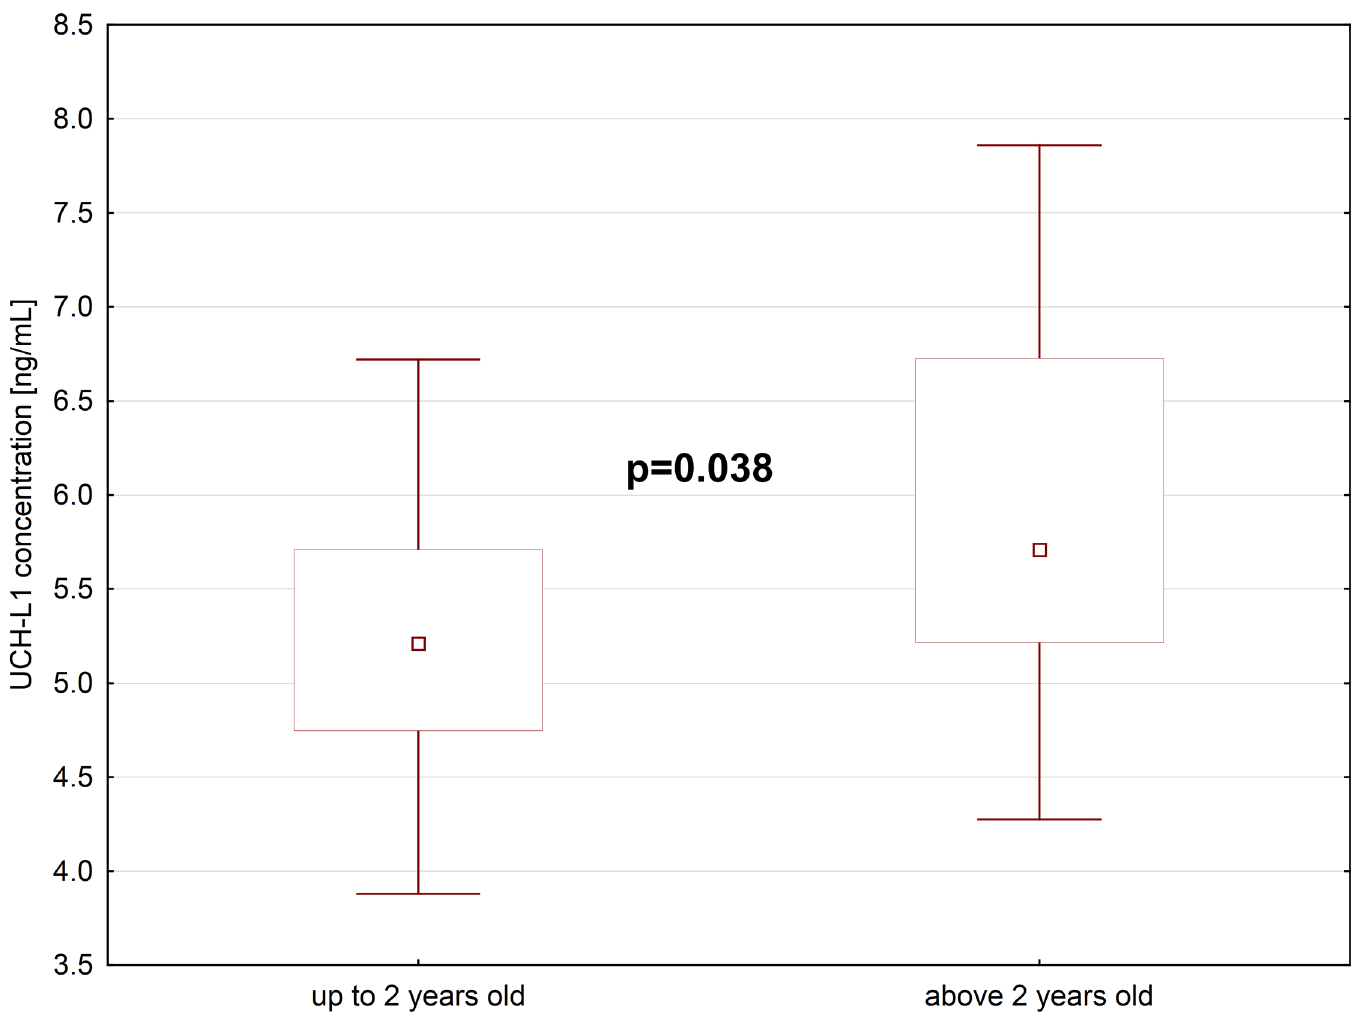
Fig 2. Plasma UCHL-1 concentration in children with cryptorchidism of age up to (N = 20) and above 2 years old (N = 30).